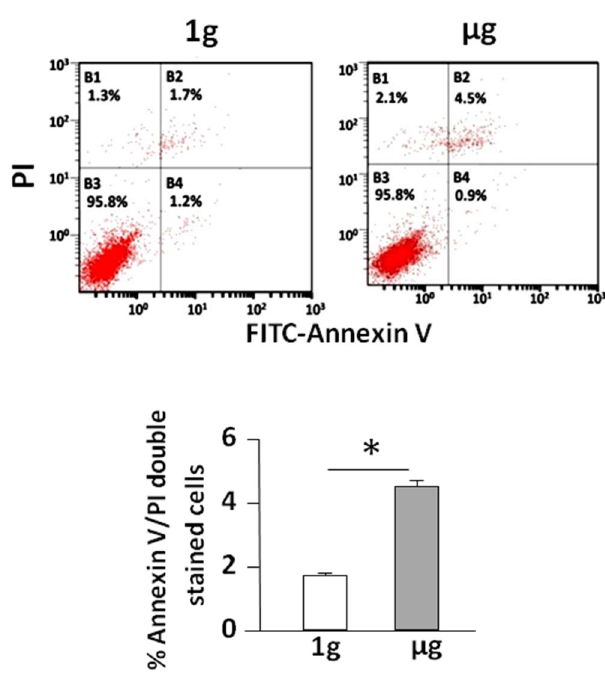
Figure 1. Simulated microgravity induces BL6-10 cell apoptosis. BL6-10 tumor cells cultured underground condition (1 g) and SMG ( µ g) for 24 h were stained with Annexin V-FITC and propidium iodide (PI), and then analyzed by flow cytometry. Data represent the mean ± SD of three independent experiments. * p < 0.05 versus different groups.